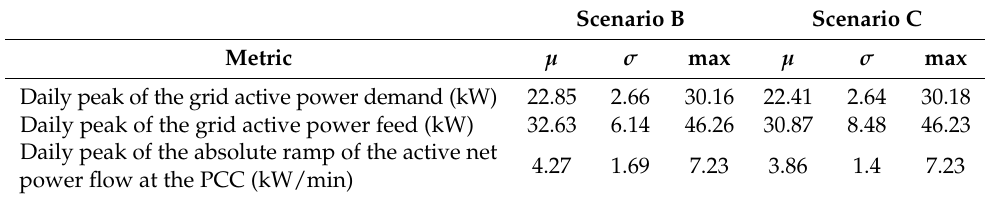
Table 12. Metrics of the active net power flow profile at the PCC with the main grid for Scenario B and C during May 2020. µ : average value, σ : standard deviation, max: maximum value.